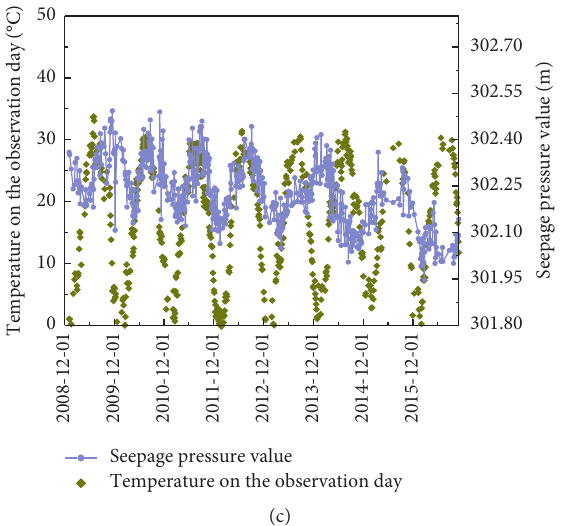
Figure 2: Long series change curve of permeability pressure value. (a) Relationship between the upstream water level and the seepage pressure. (b) Change in the seepage pressure due to rainfall. (c) Change in the osmotic pressure due to temperature.